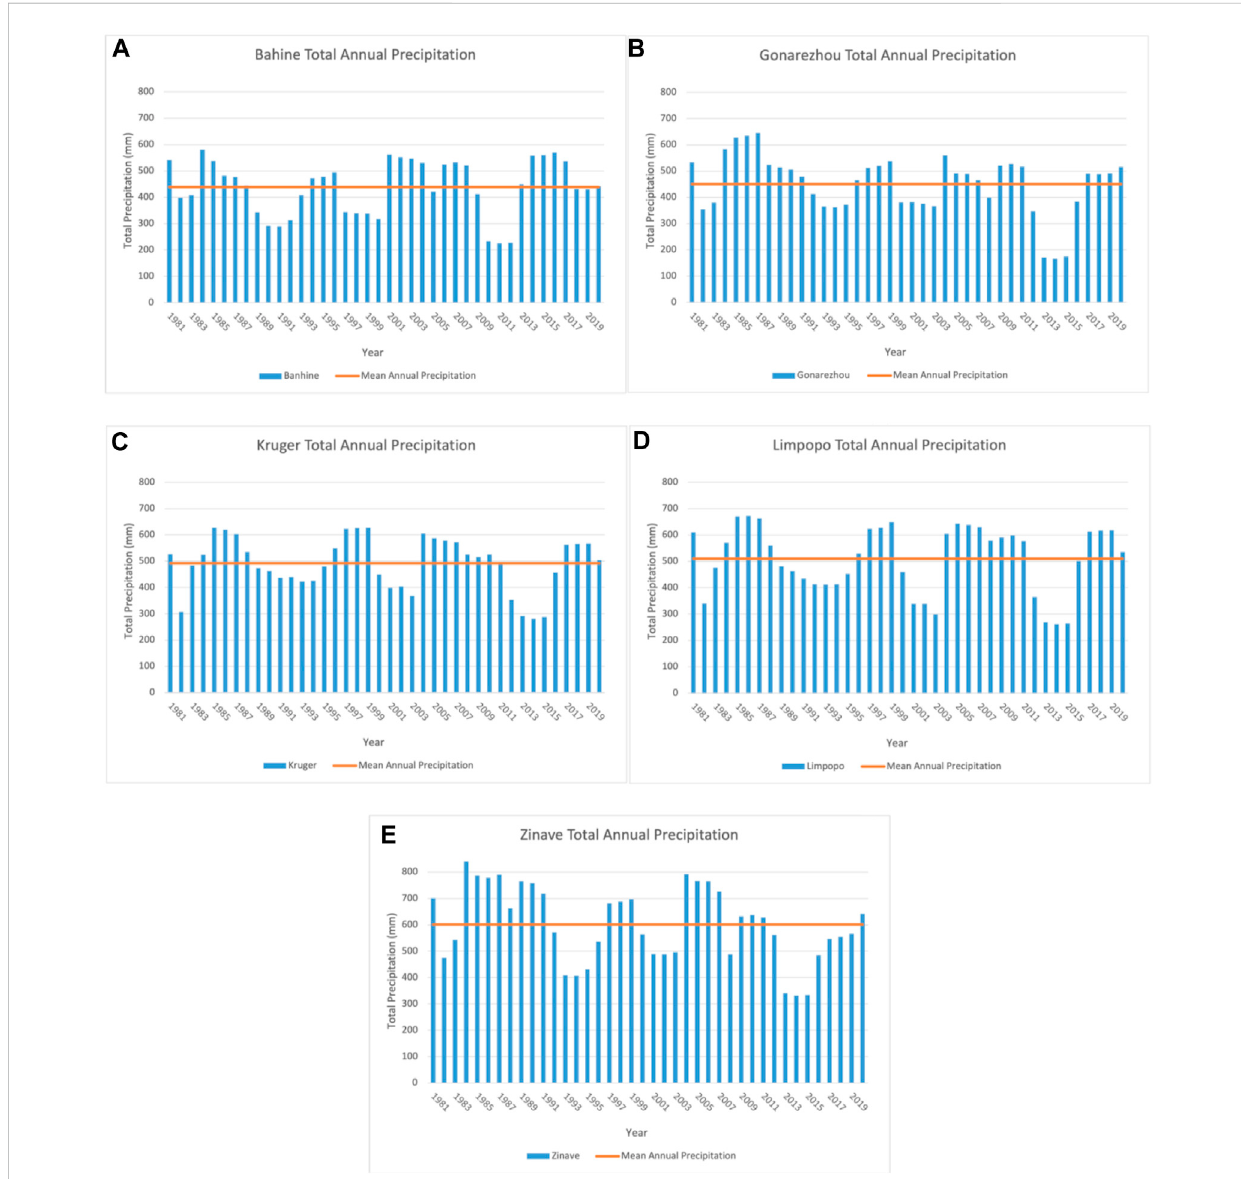
FIGURE 2 Total precipitation across the fi ve National Parks from 1981 to 2020 (with mean annual precipitation line, listed from lowest to highest in mm: (A) Bahine 439 mm, (B) Gonarezhou 451 mm, (C) Kruger 492 mm, (D) Limpopo 510 mm, (E) Zinave 602 mm.